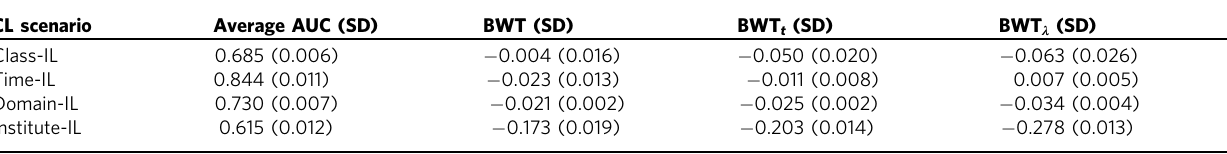
Table 2 Effect of the alternative storage mechanism, based on tracking the per-instance loss, on the performance of the continual deep-learning system.